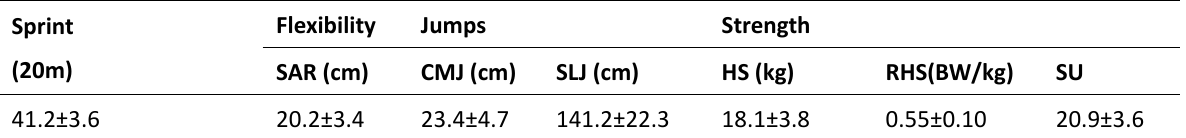
PL=posterolateral and LAT= lateral Table 2. Descriptive statistics for independent variables Sprint